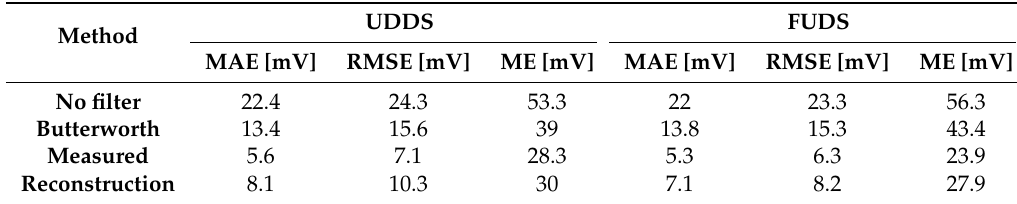
Figure 12. Simulated voltage results and errors under FUDS test at 40 ◦ C. ( a ) Comparison of the FUDS voltage and simulated voltages under FUDS test. ( b ) Simulated voltage errors with different methods under FUDS test. Table 3. Error statistics of different voltages under the UDDS and FUDS tests at 40 ◦